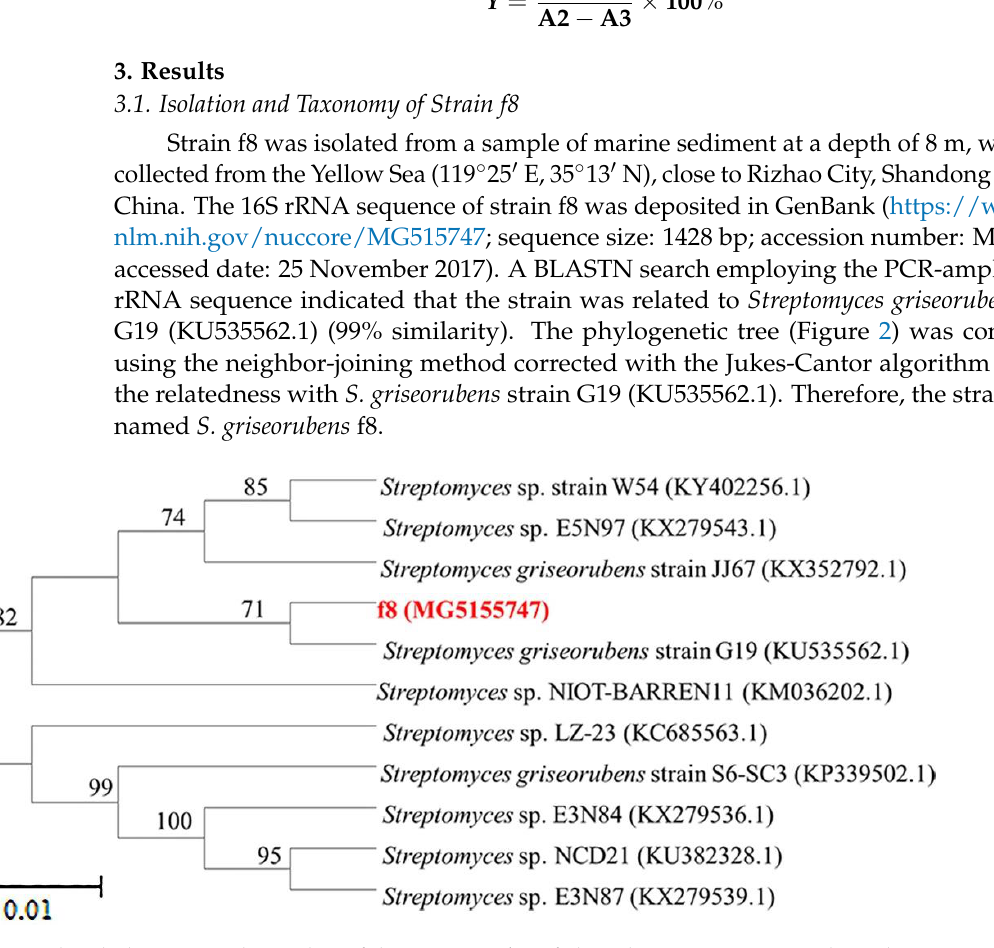
Figure 2. The phylogenetic relationship of the S. griseorubens f8 based on 16S rRNA gene homology.